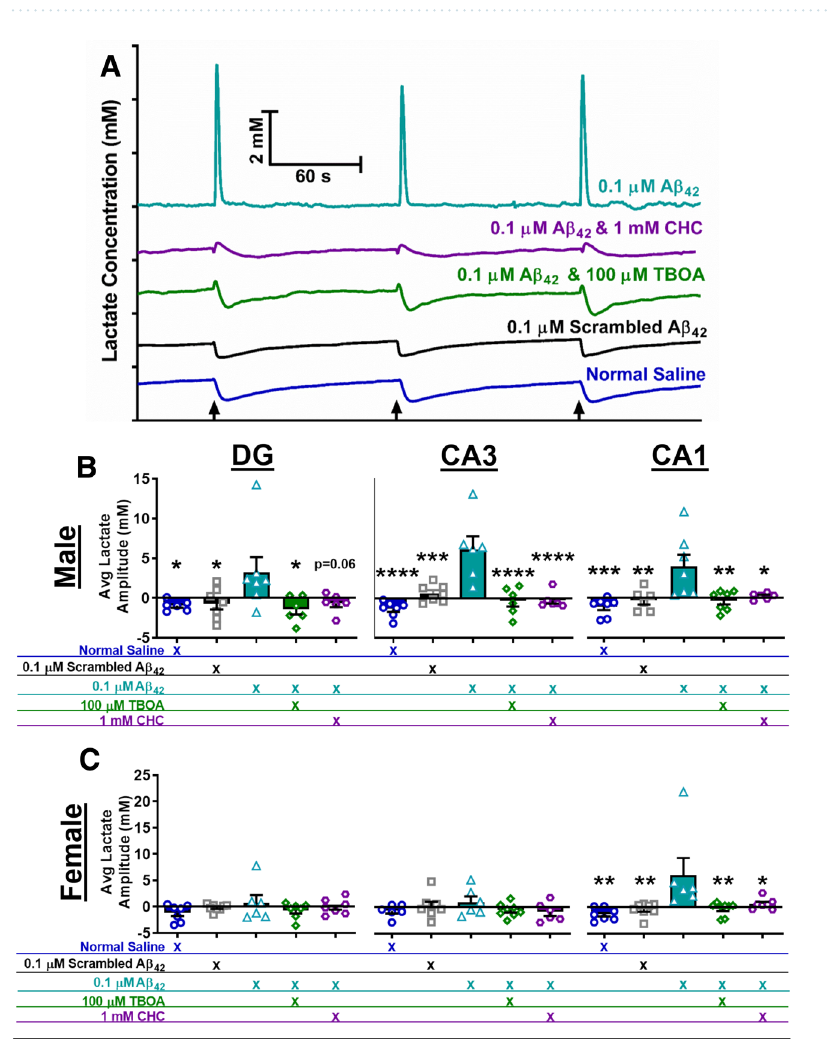
Figure 2. Efflux and inhibition of Aβ 42 stimulated lactate release. Representative traces from application of normal saline (blue), 0.1 µM Scrambled Aβ 42 (black), 0.1 µM Aβ 42 (teal), 0.1 µM Aβ 42 and 100 µM TBOA (green), and 0.1 µM Aβ 42 and 1 mM CHC (purple) are shown in ( A ). Traces are offset on the ordinate to clearly show lactate dynamics and black arrows indicate time point of pressure ejection. Average maximal change in lactate levels from baseline after application of each compound for each hippocampal subregion of male ( B ) and female ( C ) C57BL/6 J mice. The legend under the graph indicates the compounds that were locally (co)applied. *p < 0.05, **p < 0.01, ***p < 0.001, ****p < 0.0001; n =